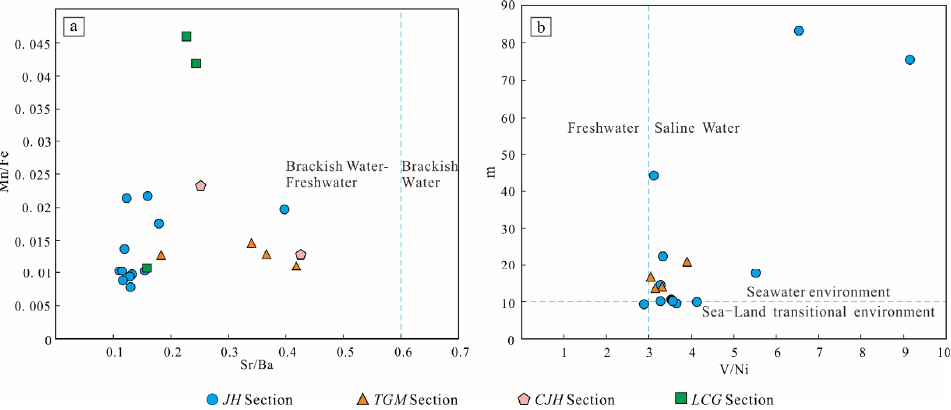
Figure 10. Diagrams of paleo-salinity changes in the Xu-3 Member (CJH and LCG data from [32]). ( a ) Sr/Ba-Mn/Fe correlation diagram; ( b ) V/Ni-m correlation diagram. ( a ) Sr/Ba-Mn/Fe correlation diagram; ( b ) V/Ni-m correlation